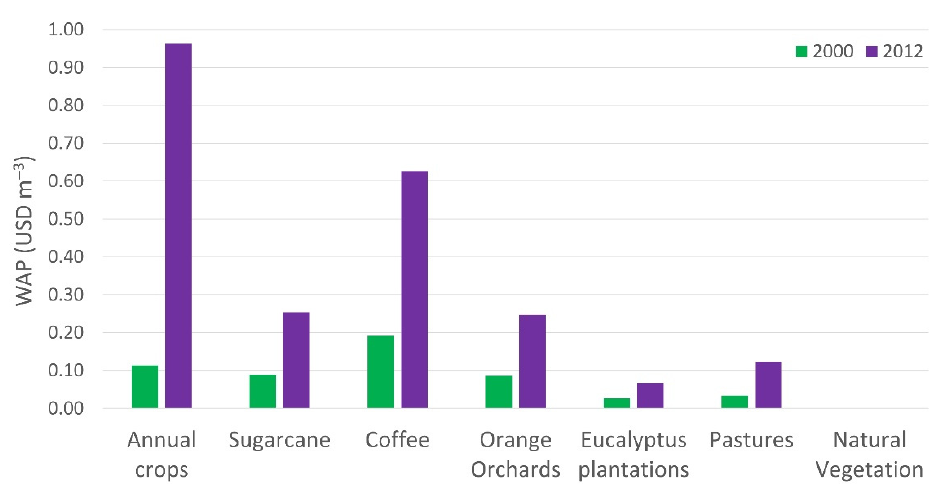
Figure 5. Water apparent productivity WAP for all land uses for the years 2000 and 2012. The total ES value averaged over 2000–2012 was the highest for pastures with 66.5 USD ha − 1 , whereas sugarcane had a value of 35.8 USD ha − 1 . In terms of ES value per unit of water, pastures, natural areas, and eucalyptus plantations provide the highest values, with an average of 0.0079 USD m − 3 , 0.0071 USD m − 3 , and 0.0069 USD m − 3 , respectively. Despite the differences in the average values, the variability in the results does not allow the ability to define sharp differences among these three land uses (Figure 6). Orange orchards and annual crops have lower values than these land uses, with values of 0.0068 USD m − 3 and 0.0075 USD m − 3 on average. Relative to their water consumption, sugarcane and coffee plantations are not efficient water uses in terms of ES generation, with 0.0035 and 0.0046 USD m − 3 of ES value generated during 2000–2012, despite their improvement over the